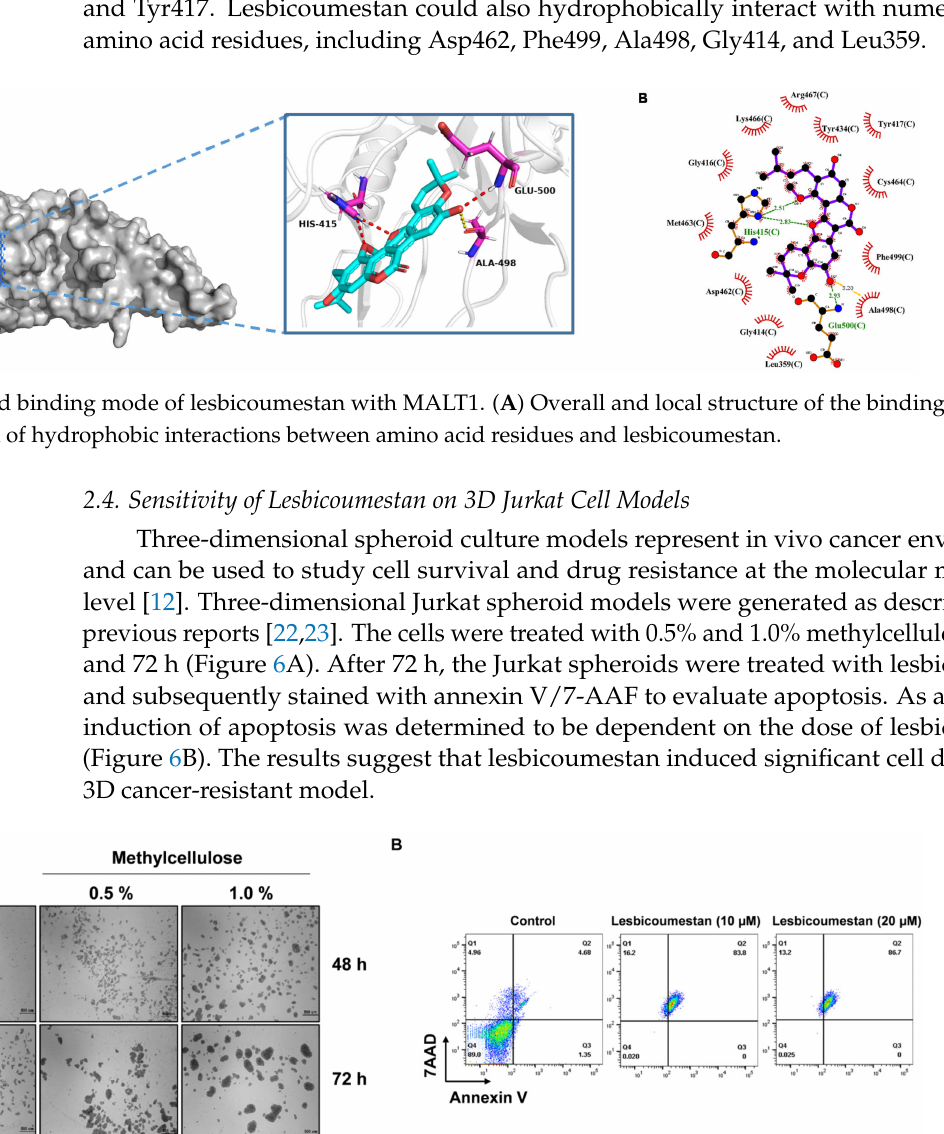
Figure 6. Effect of lesbicoumestan on a 3D Jurkat cell resistance model. ( A ) Representative images of methylcellulose- mediated spheroid formation on Jurkat cells. Cells were seeded in ultra-low-attachment 6-well flat bottom plates and treated with methylcellulose with concentrations of 0.5–1.0% for 48–72 h. Scale bar, 500 µ m ( n = 3 for each experiment). ( B ) Jurkat cells treated with the indicated concentrations of lesbicoumestan. Flow cytometry was employed to assess the cellular apoptosis of the 3D Jurkat cells 48 h post-treatment ( n =